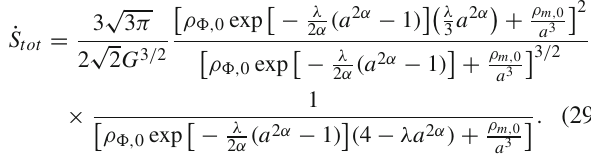
analysis as in the previous section. Now, total energy density is ρ tot = ρ + ρ (cid:3) . The general form of the rate of change of the total entropy remains same as equation (25). As a conse- quence of modification of the Friedmann equations due the contribution of the CDM, one obtains the explicit form of ˙ S tot